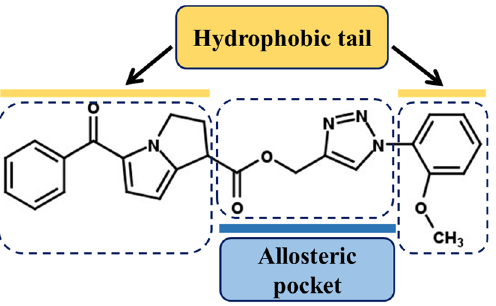
Figure 13. Structure–activity relationship showing the proposed binding orientation of 15K with PAK1 protein